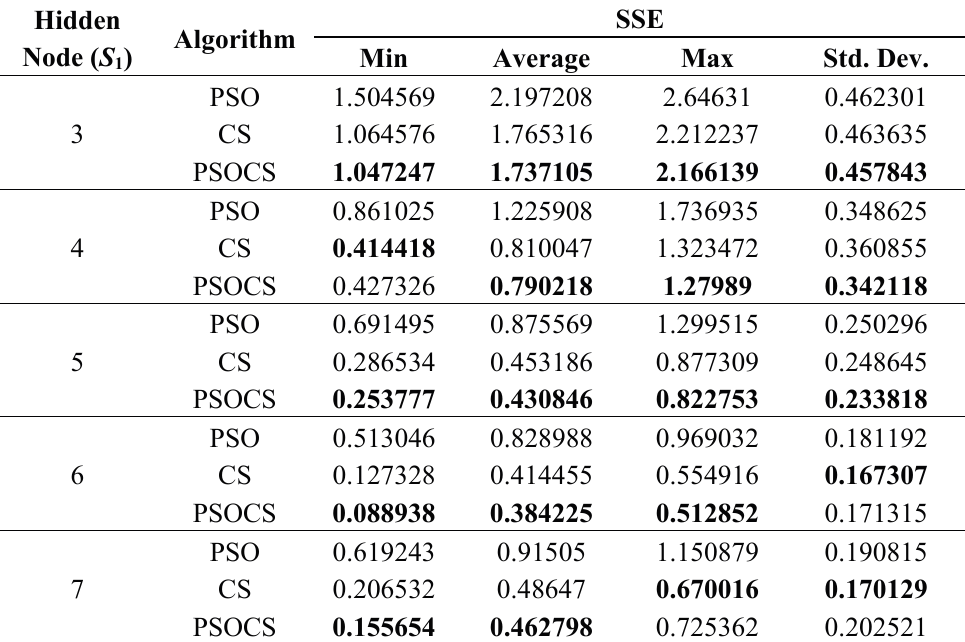
Table 1. The performance comparisons of the PSO-FNN, CS-FNN, and PSOCS-FNN in the function approximation